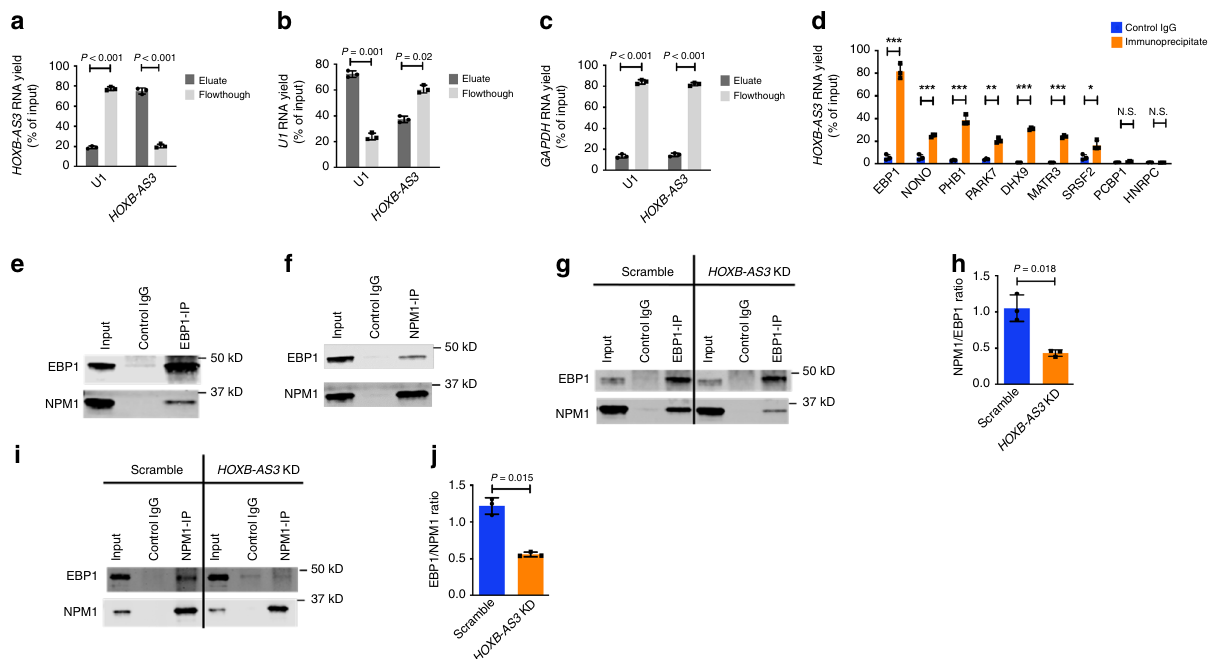
Fig. 4 EBP1 strongly interacts with HOXB-AS3 in NPM1 mut AML cells. a – c Yields of a HOXB-AS3 RNA, b U1 RNA, and c GAPDH RNA in the eluates and the fl ow-through of lysates hybridized with U1 and HOXB-AS3 -targeting probes. The RNA yield is depicted as a percentage of the amount of the respective transcript in the input sample. d Validation of HOXB-AS3 -protein interactions via RNA-Immunoprecipitation (RIP) experiments with nine candidate proteins. Enrichment of each immunoprecipitate is compared with the respective IgG control (mouse or rabbit). * P < 0.05, ** P < 0.005, *** P < 0.001, N.S., not signi fi cant. e Immunoprecipitation of the EBP1 protein in nuclear lysates of OCI-AML3 cells followed by western blotting (WB) for the EBP1 and NPM1 proteins. f Immunoprecipitation of the NPM1 protein in nuclear lysates of OCI-AML3 cells followed by WB for the EBP1 and NPM1 proteins. g – j Effect of HOXB-AS3 depletion ( HOXB-AS3 KD) on the formation of the EBP1-NPM1 complex in OCI-AML3 cells: g EBP1 immunoprecipitation in scramble versus HOXB-AS3 KD-treated cells followed by WB for the EBP1 and NPM1 proteins. h Quanti fi cation of three independent experiments. i NPM1 immunoprecipitation in scramble versus HOXB-AS3 KD-treated cells followed by WB for the EBP1 and NPM1 proteins. j Quanti fi cation of three independent experiments. P values were calculated using paired two-sided t -tests. In the fi gures, heights of boxplots indicate mean values with standard deviation. Error bars indicate highest and lowest values in each population. Source data are provided as a Source Data fi